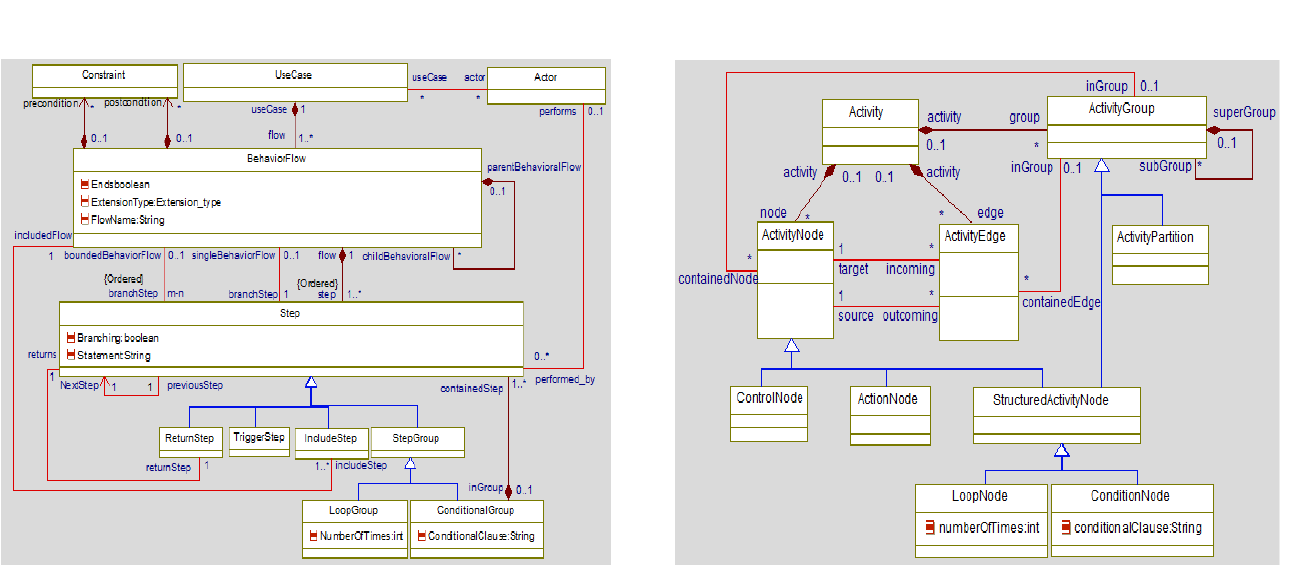
Figure 4 . Use case Meta-model Figure 5 . Activity